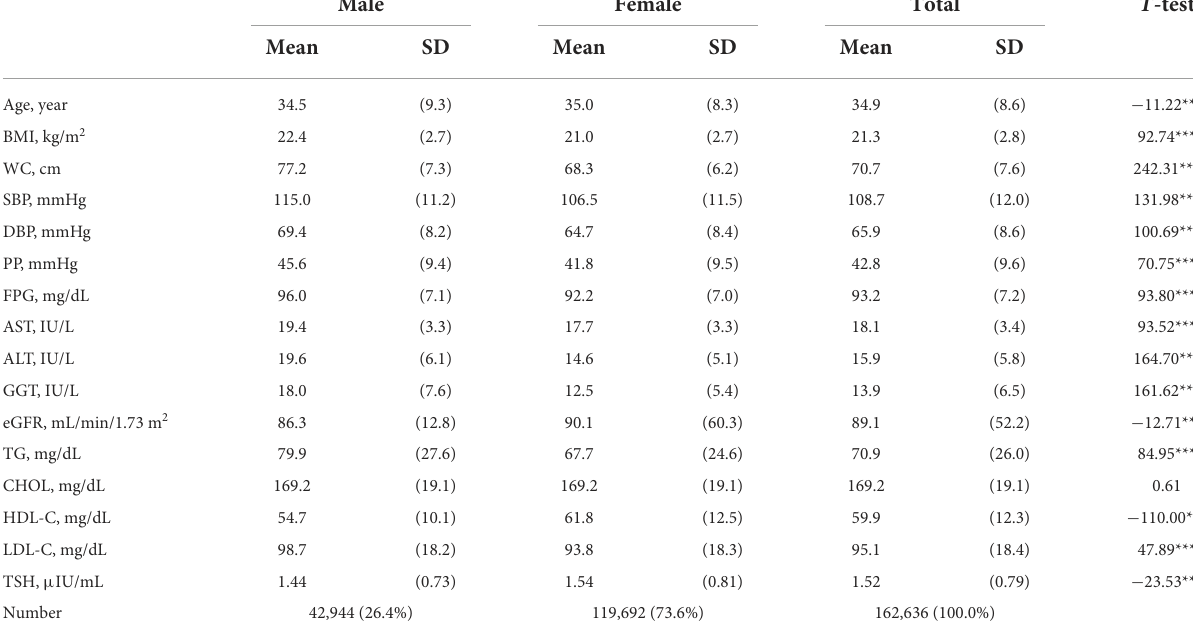
TABLE 1 Clinical and laboratory characteristics of